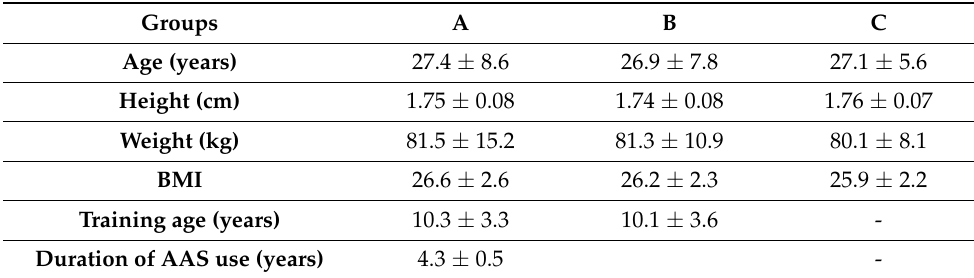
Table 1. Physical characteristics of the study population (mean ± S.D.). Groups